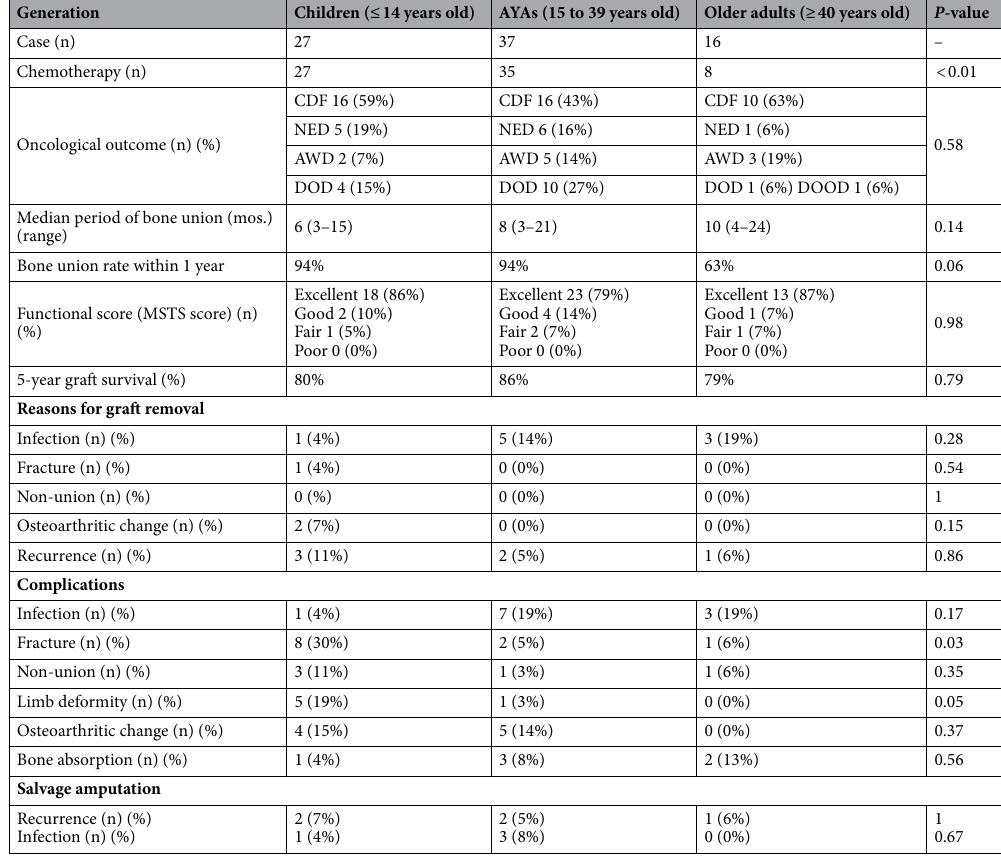
Table 2. The clinical outcomes and complications in the patients who underwent frozen autograft reconstruction on the appendicular skeleton in the three age groups. CDF clinically disease-free, NED no evidence of disease, AWD alive with disease, DOD dead of disease, DOOD dead of other diseases, MSTS Musculoskeletal Tumor Society.